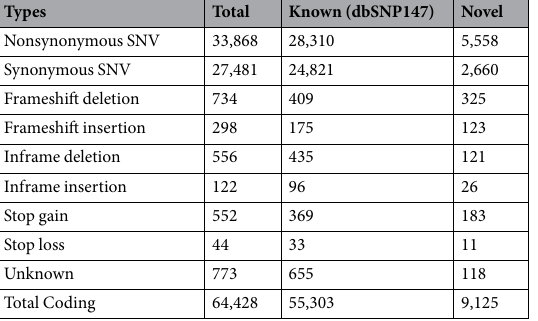
Table 1. Summary of Exonic Variants in